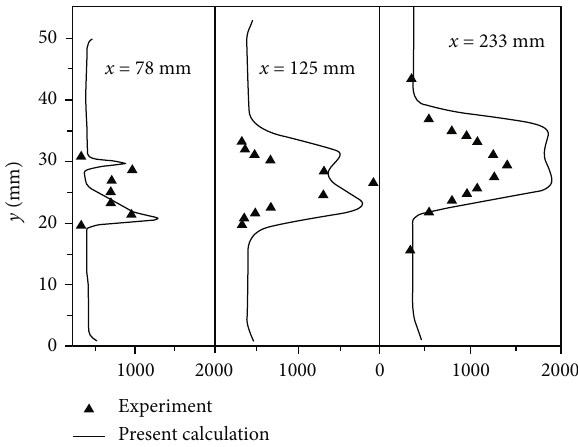
Figure 5: Distribution of the temperature obtained from experiment and simulation.